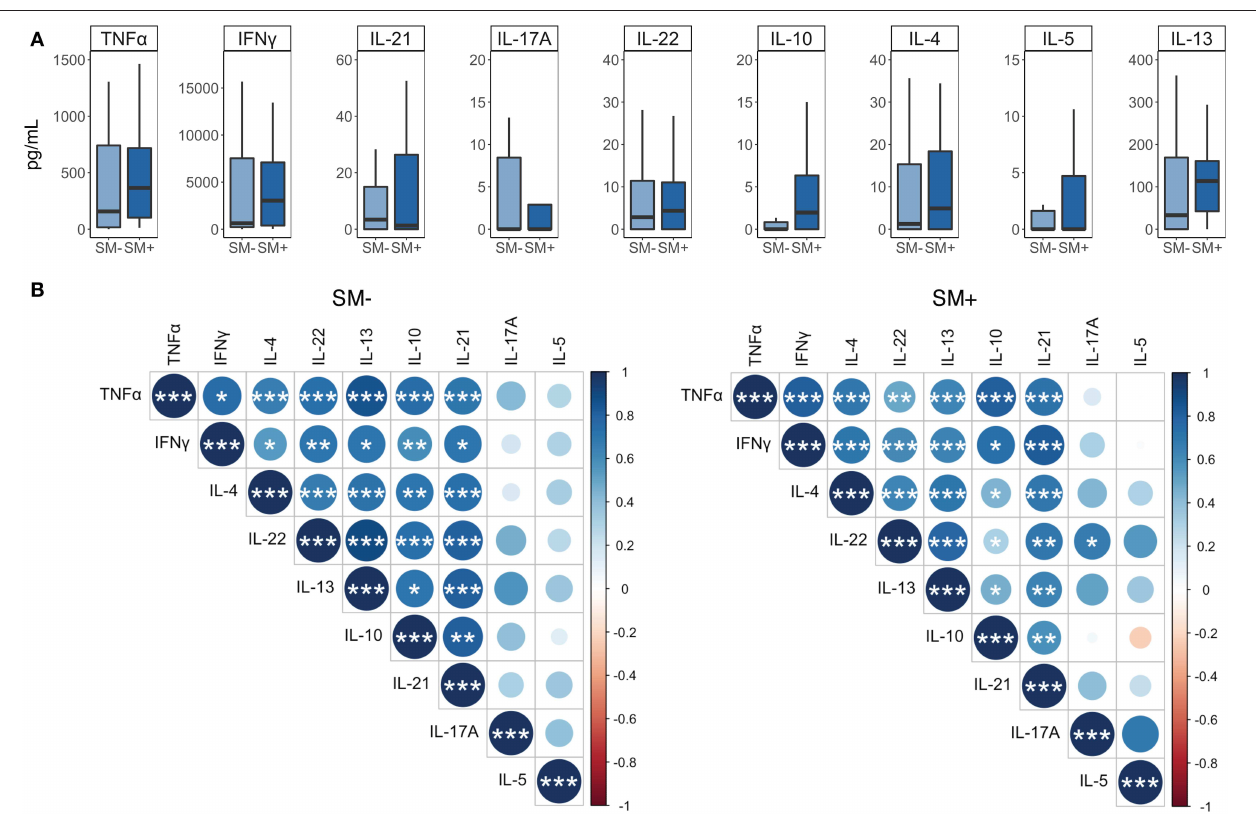
FIGURE 8 | IFN γ is more strongly correlated with the production of additional cytokines in SM + than in SM − LTBI individuals. Supernatants were collected from PBMCs incubated for 5 days under the following conditions: media alone (negative control) or CFP-10 and ESAT-6 peptide pools. (A) Levels of each cytokine were quantified by Luminex (SM − , n = 22; SM + , n = 22). Data are shown after background subtraction of the respective cytokine in the negative control condition. Boxes represent the median and interquartile ranges; whiskers represent the 1.5*IQR. Differences in the amount of each cytokine between SM + and SM − individuals were assessed using a Mann Whitney U -test. (B) Correlogram plots of each cytokine, separated by SM infection status. Correlations were evaluated using a non-parametric Spearman rank correlation. Positive correlations are displayed in blue and negative correlations in red. Color intensity and the size of the circle are proportional to the correlation coefficients. Cytokines within each plot were ordered using the centroid method of hierarchical clustering within the SM − data. This order was then applied to the SM + data. *** p < 0.001; ** p < 0.01; * p <